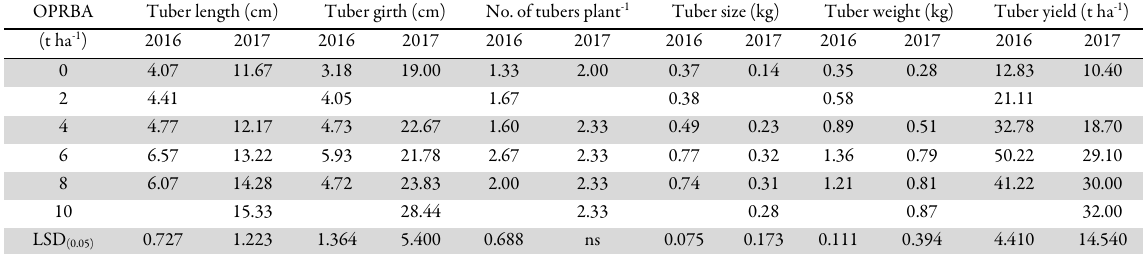
Table 4. Sweet potato tuber yield and its components as influenced by oil palm refuse bunch ash (OPRBA) OPRBA